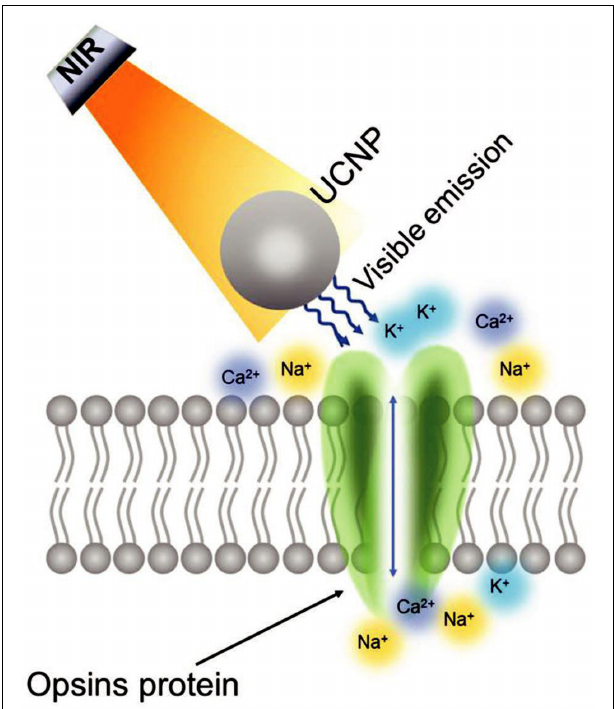
FIGURE 3 | Near-infrared optogenetic stimulation. Schematic principle of lanthanide-doped upconversion nanoparticle (UCNP) mediated NIR optogenetic stimulation (Copyright permission was obtained from the publisher; Yu et al.,